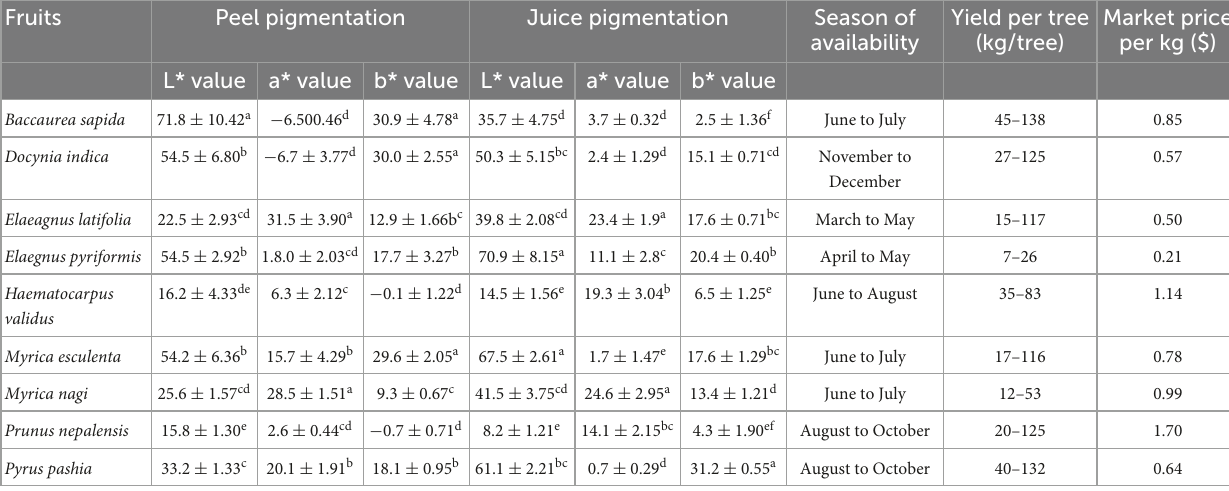
Yield per tree Market price availability (kg/tree) per kg